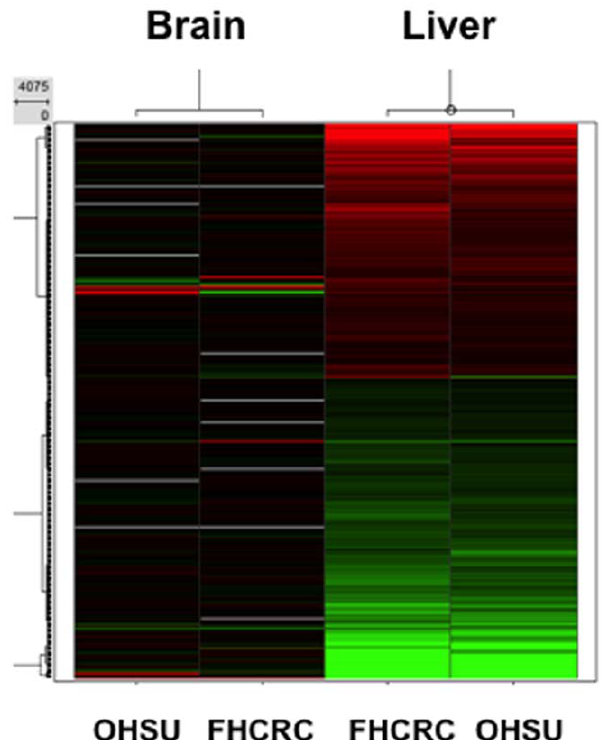
Figure 1. Heat map comparing the post-treatment (6 hr) transcriptional response of brain and liver (positive control) of wt mice to a single intraperitoneal dose of MAM. The experiment was conducted at two independent laboratories using identical protocols. Green denotes down-regulation and red up- regulation of gene expression. OHSU: Oregon Health & Science University. FHCRC: Fred Hutchinson Cancer Research Center.